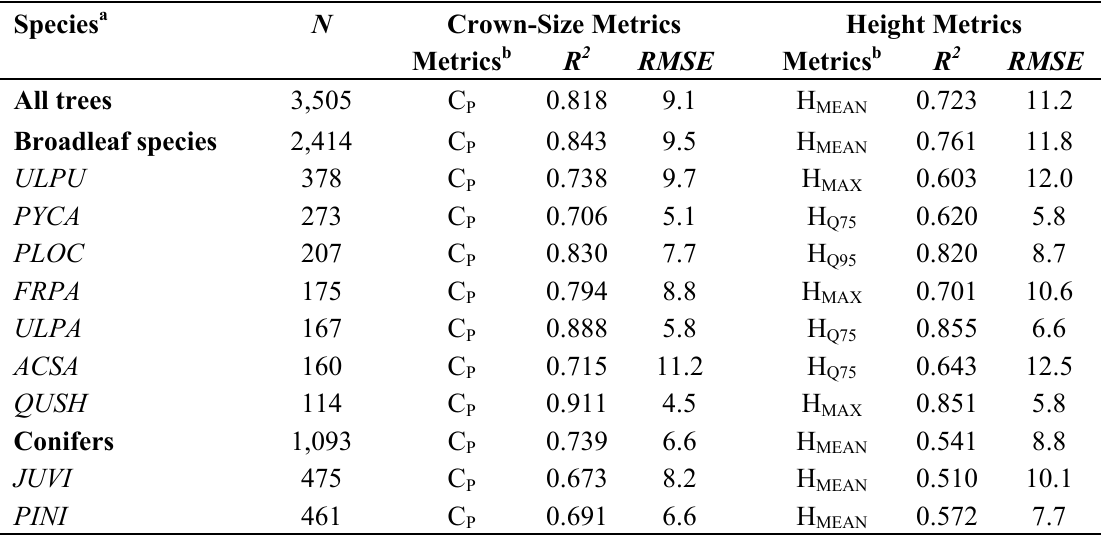
Table 8. Relationship of diameter at breast height (cm) with crown-size and height